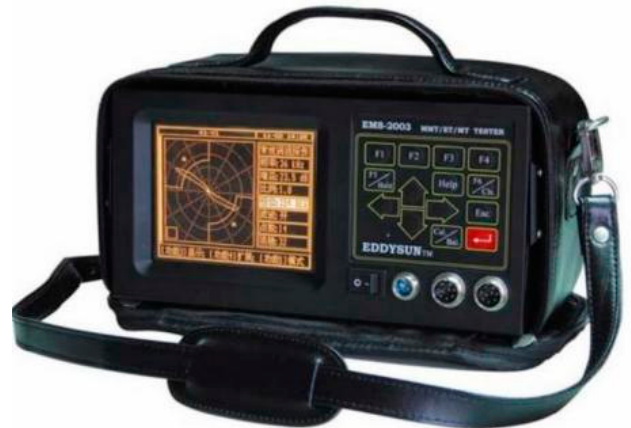
Figure 7. EMS-2003 metal magnetic memory detector.